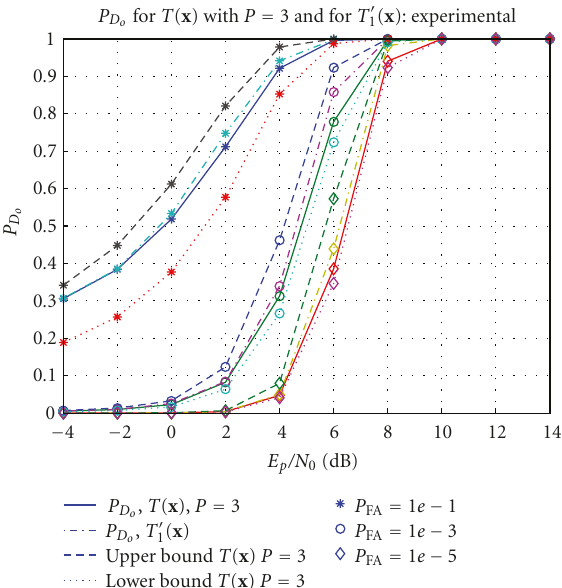
Figure 10: MSE performance for δ estimation with various L w ’s. Figure 8: Experimental P D for T ( x ) with P = 3 and T (cid:13) 1 ( x ) . o 500 Monte Carlo runs are used to evaluate the mean squared error (MSE) of h δ versus SNR. In each run, the The noise samples may be mistakenly weighted heavily under timing o ff set and the channel are randomly generated. ( x ) accumulates real circumstances. On the other hand, T (cid:13) The results for the symbol-long estimates and the L w -long 1 all the frame samples in the observation window, which is estimates assuming perfect timing are shown in Figure 9. equivalent to equally weighting. According to these results, The MF curves (dotted lines) always have the highest noise ( x ) because of its simplicity and similar we can employ T (cid:13) floor, since the MF output is the convolution of the chan- 1 performance as T ( x ). nel energy vector with the code autocorrelation